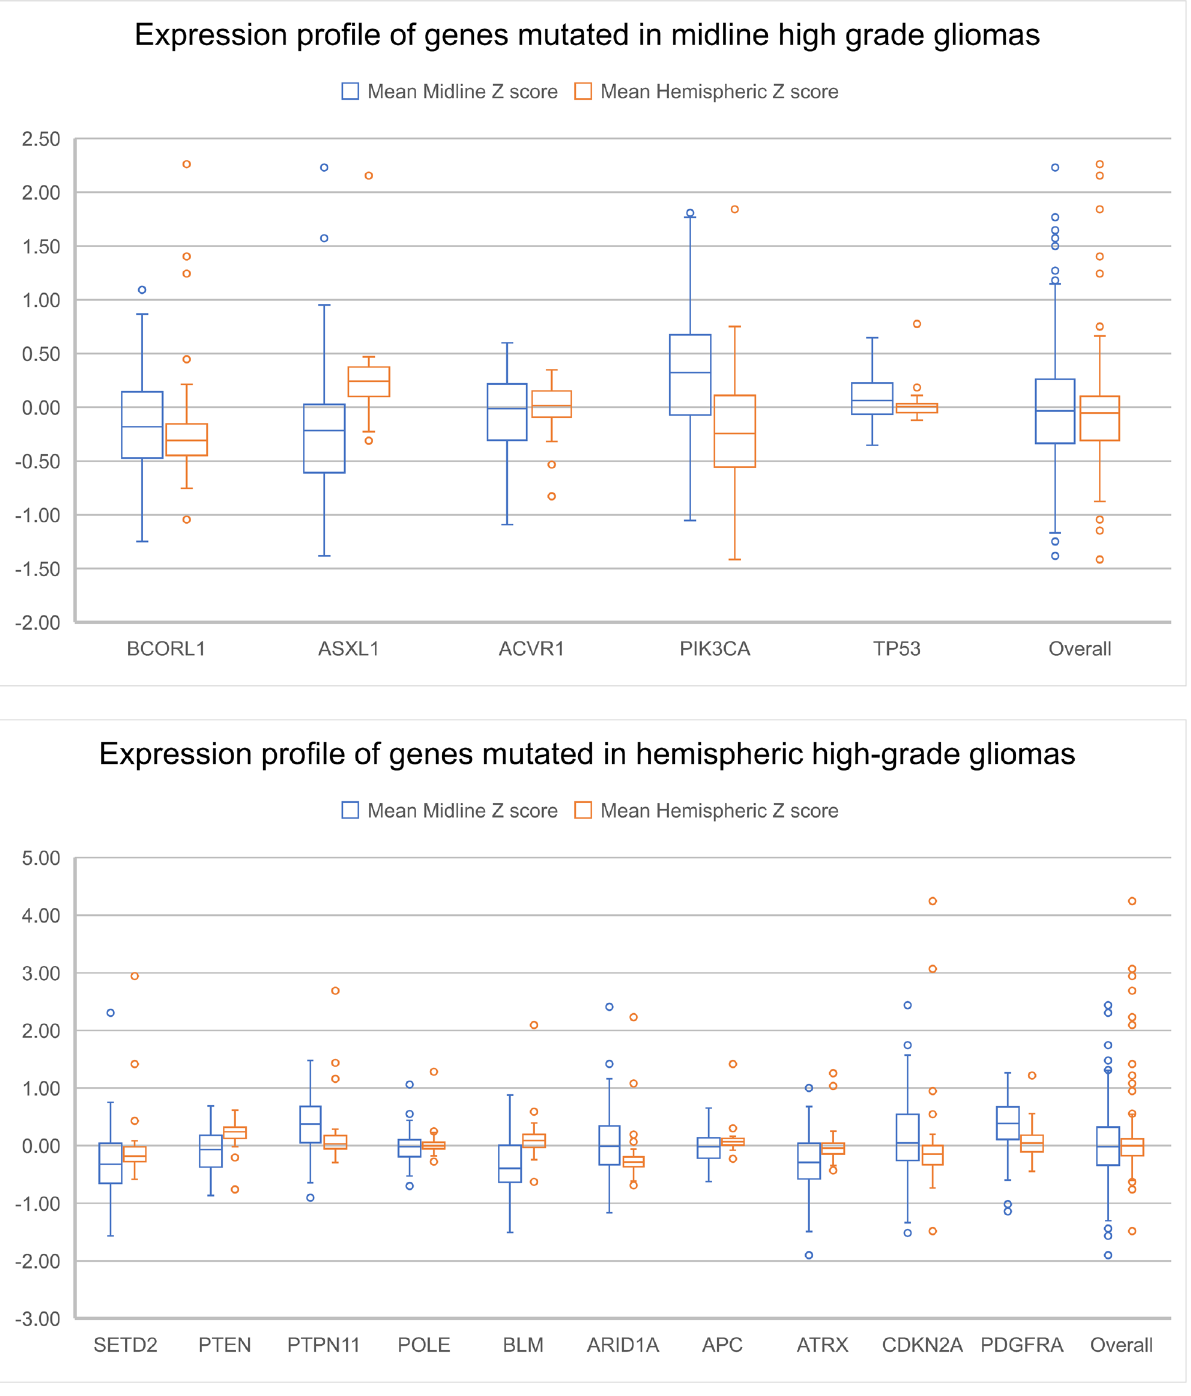
Figure 2. Expression profile of genes mutated in midline and hemispheric high-grade